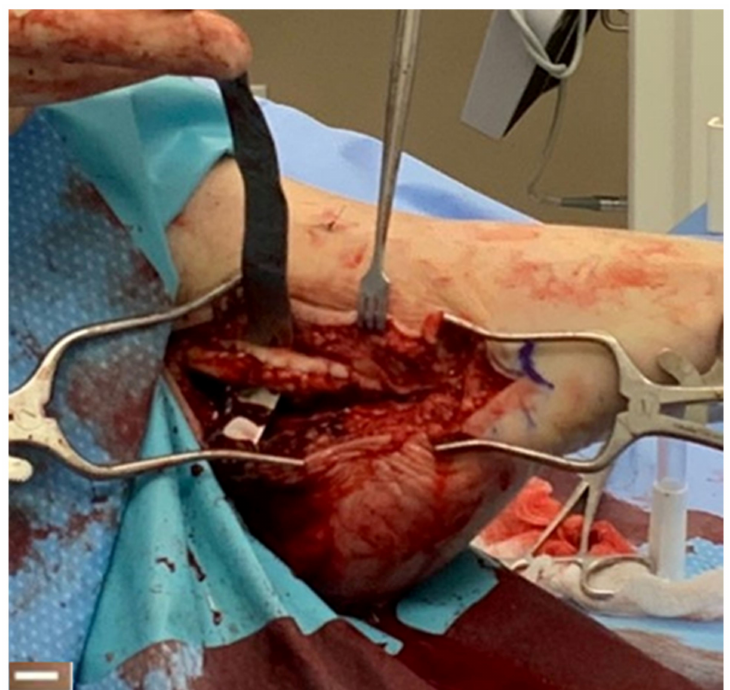
Figure 8. Tendon repair using the synthetic hybrid-scale fiber matrix. Scale bar represents 1